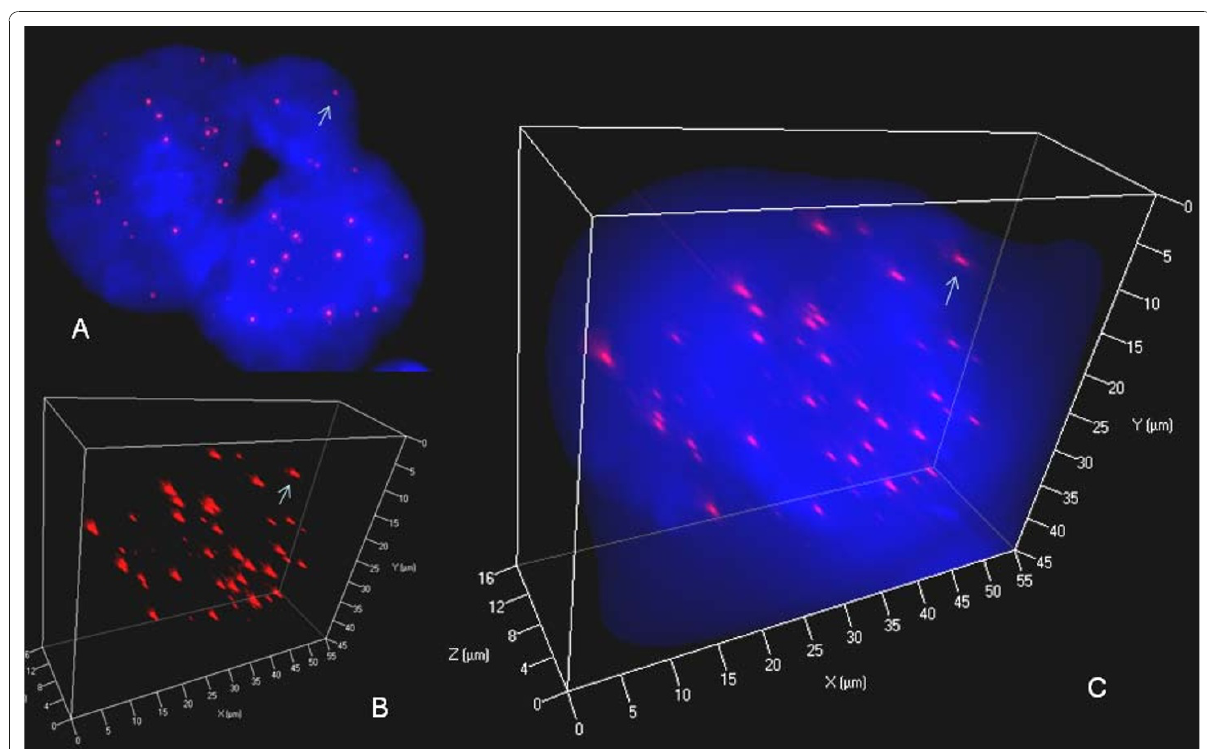
Figure 7 3D nuclear staining of telomeres and DNA in U-HO1-PTPN1 RS-cells . A. Representative 2D Z-stack image no. 37 out of 80 shows a tri-nuclear RS-cell composed of two large and one small telomere-poor “ ghost ” satellite nucleus. Arrow identifies a mid-sized telomere also shown in B and C. B. 3D reconstruction in surface mode reveals relatively few (compared to cellular volume) mid-sized and short telomeres. Very short telomeres including t-stumps are rare. C. Combined 3D nuclear staining confirms 3D telomere dynamics identical to those observed in precursor H-cells (see Figure